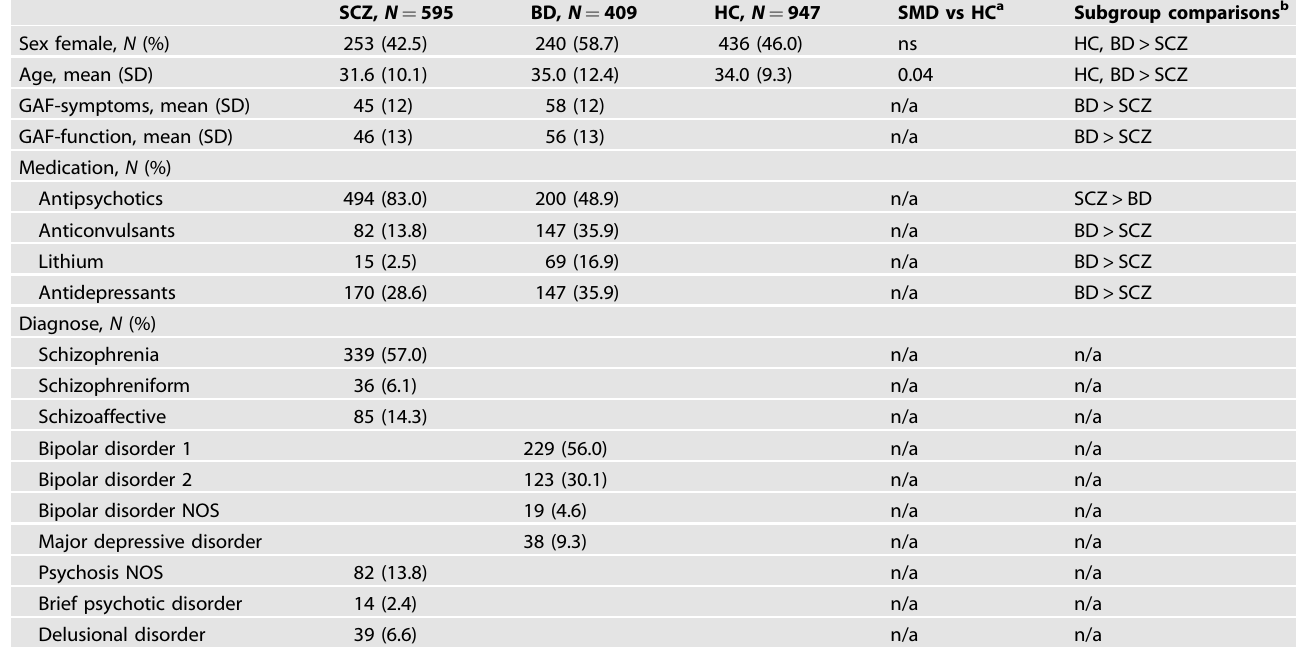
Table 1. Demographics and clinical